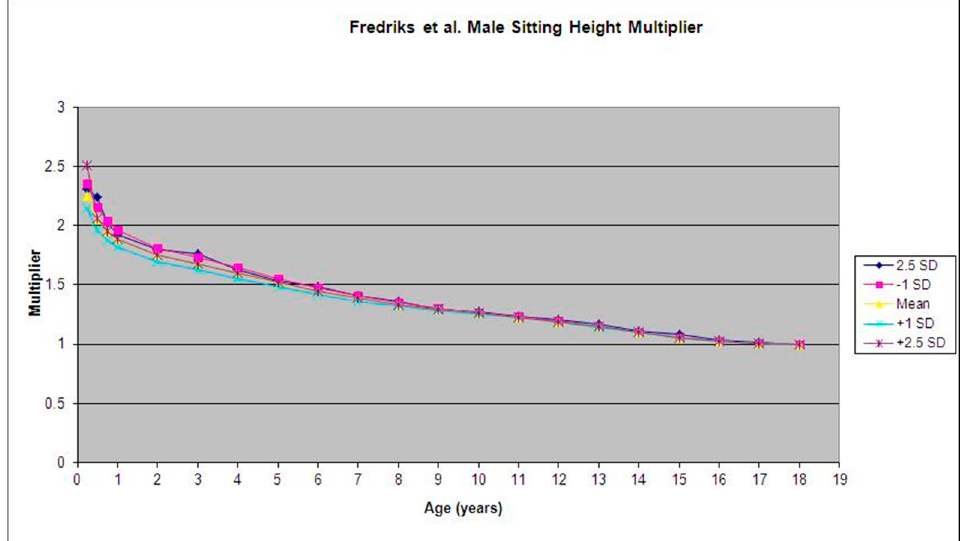
Figure 2. Mean and standard deviation for the male sitting height multiplier were calculated using data from Fredriks et al. [9].